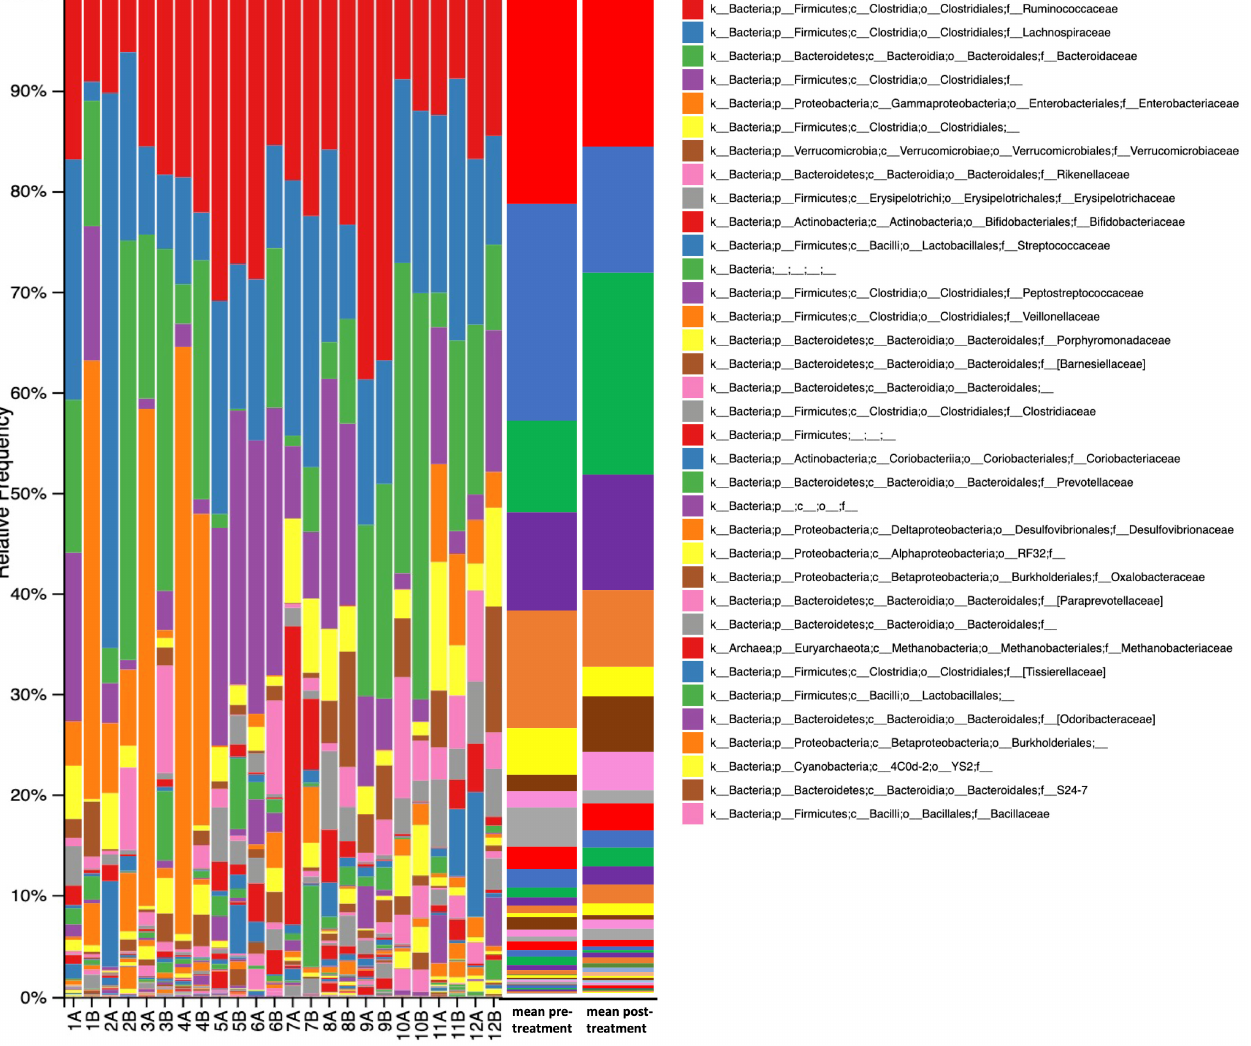
Figure 3. Stacked bar chart indicating the relative abundances of the 35 most abundant genera detected in the gut microbiomes of PD participants before (pre-) and after 12 weeks (post-) of PBM treatment. A = pre-treatment; B = post-treatment.